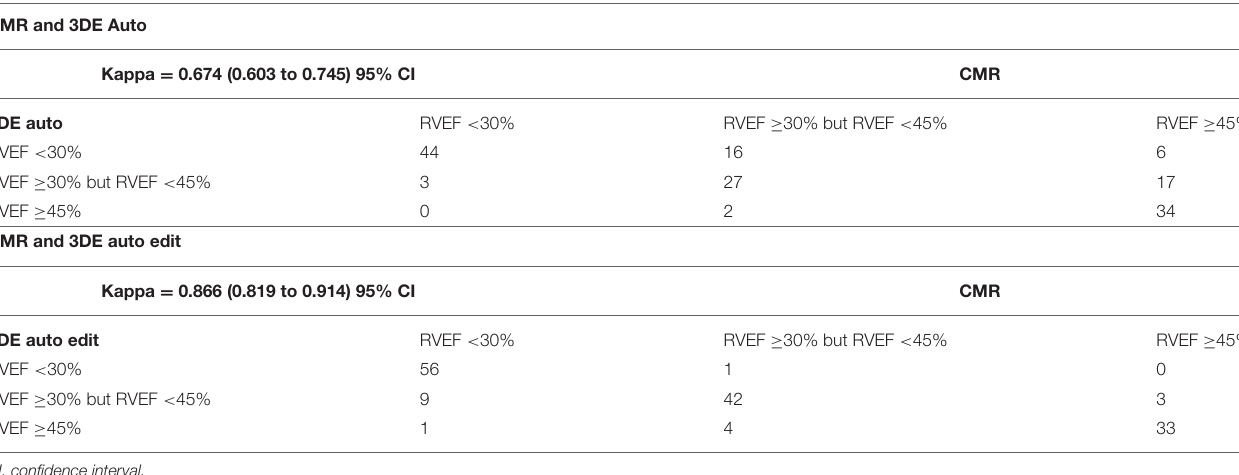
TABLE 4 | The agreement of categorization between 3D auto RV with/without manual edit and CMR.